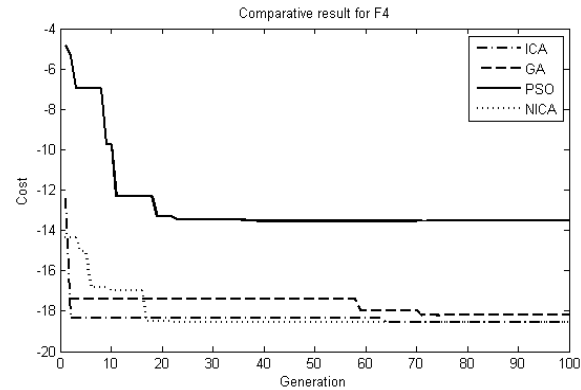
Figure 6. The cost of F4 function.